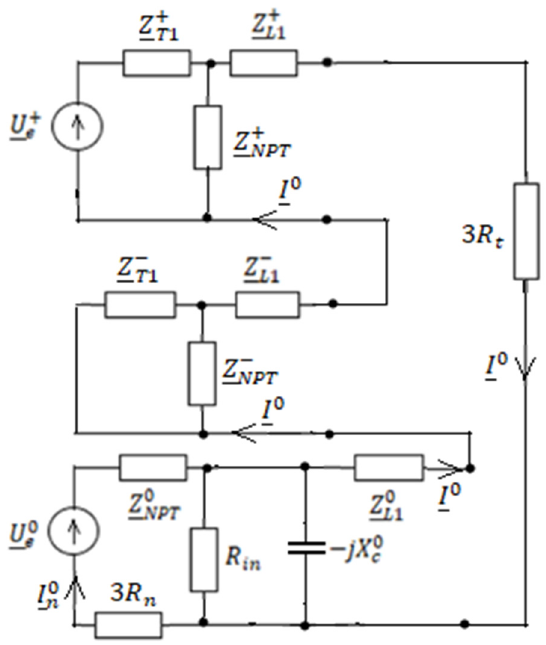
Figure 3. Connection of sequence diagrams in case of a phase–ground fault.